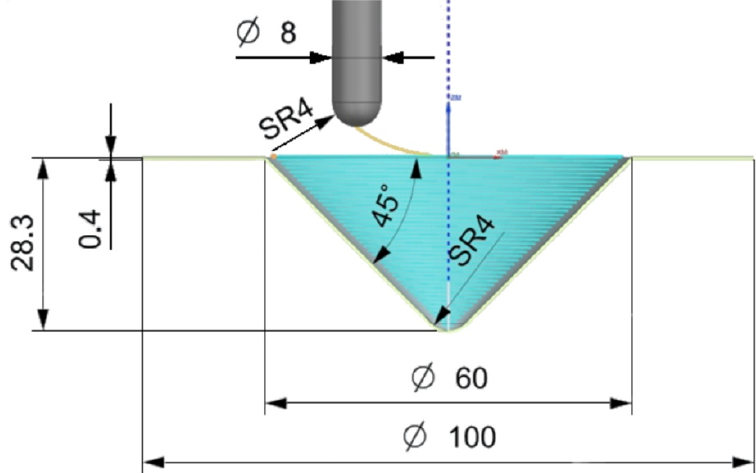
Figure 2. Drawpiece geometry and tool path generated in NX Siemens PLM.